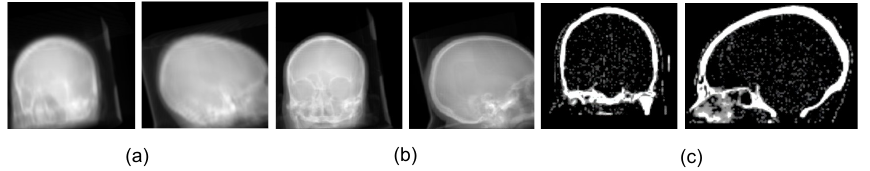
Figure 13. ( a ) DRRs of Case 3; ( b ) DRRs of Case 4; ( c ) CT image of Case 7. ( a , c ) are two failure cases using the proposed method. While ( b ) is a successful